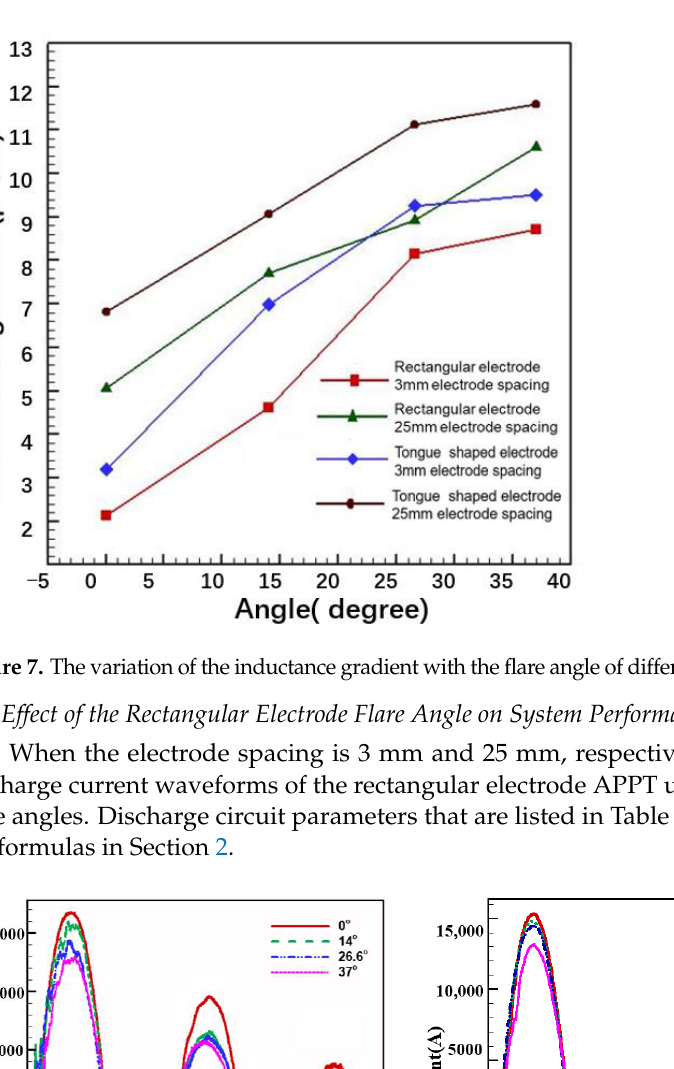
Figure 8. The rectangular electrode APPT discharges current waveforms at various flare angles: ( a ) the electrode spacing is 3 mm and ( b ) the electrode spacing is 25 mm. Table 1. T he APPT discharge circuit parameters with the rectangular electrode with different flare angles. Electrode Spacing